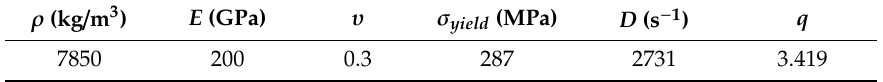
Table 4. Mechanical properties of mild steel